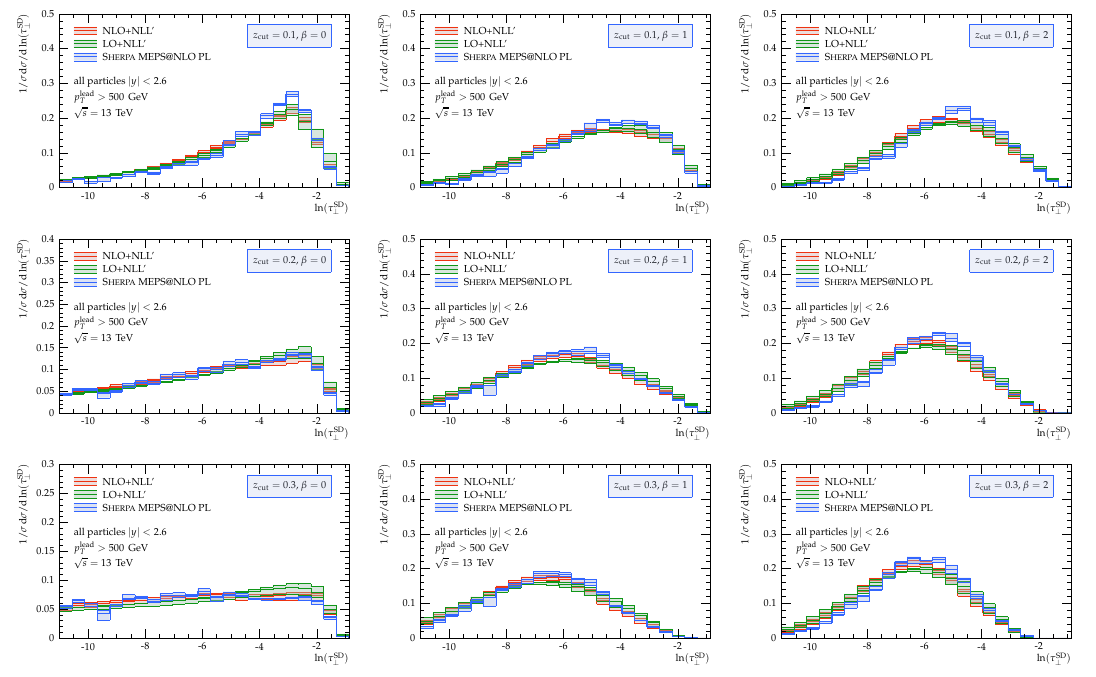
Figure 11 . Same as figure 10 but for the p T, min = 500 GeV event